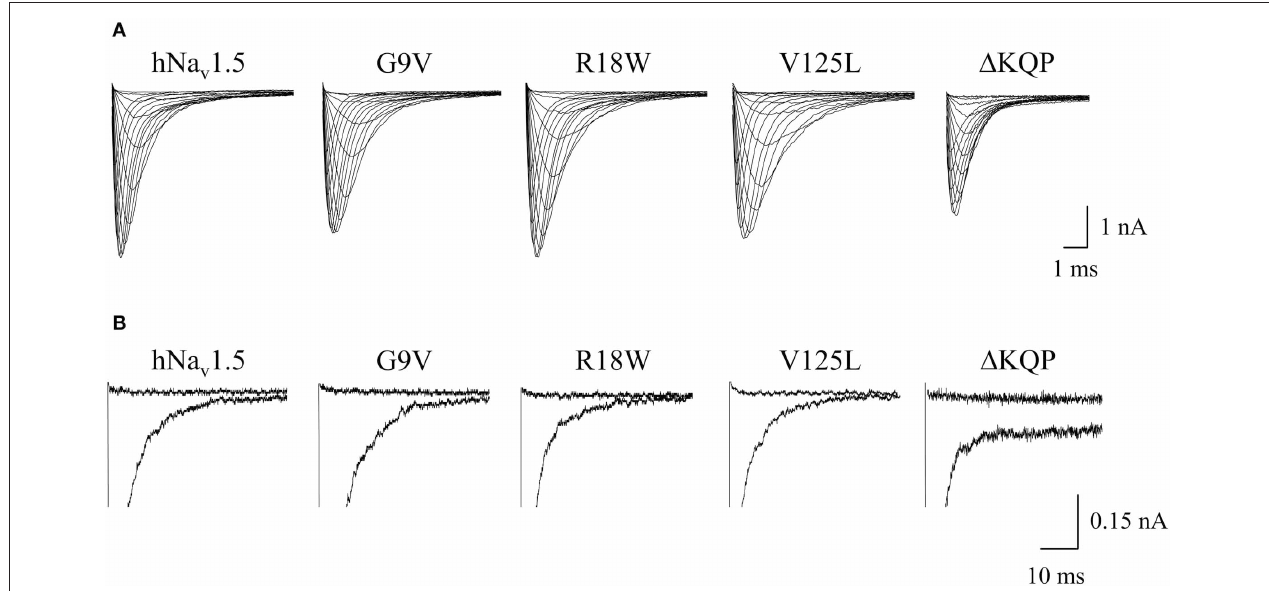
FIGURE 2 | Whole-cell Na + currents upon expression in HEK293 of hNa v 1.5 mutant channels associated with LQT3. (A) Current families. Currents were elicited by test potentials from − 80mV to various test pulses in 5 or 10mV increments at a pulsing frequency of 1.0Hz. (B)